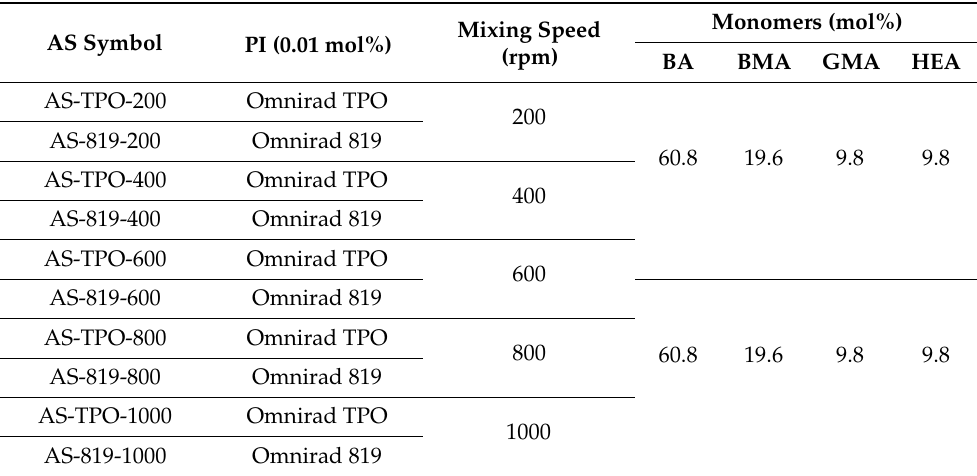
Table 1. The composition of monomer/photoinitiator systems used for ASs preparation (at different mixing